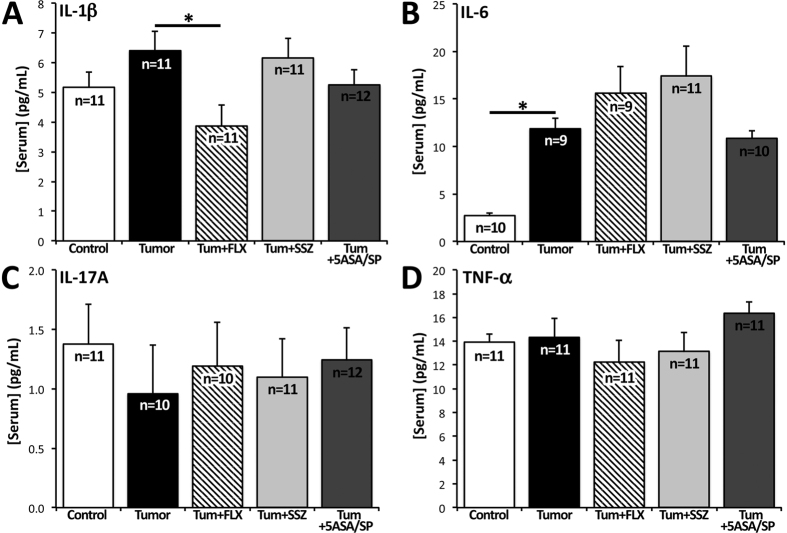
Serum level of pro-inflammatory cytokines for the 5 experimental groups: control, tumour, tum+FLX, tum+SSZ, tum+5-ASA/SP.(A) FLX-treated mice had a significantly lower level of serum IL-1β compared to untreated tumour mice (P = 0.022). (B) Untreated tumour-bearing mice had higher levels of serum IL-6 compared to control mice (P = 0.015). (C) Serum IL-17A did not differ between any experimental groups. (D) Serum TNF-α did not differ between any experimental groups. Data are presented as mean ± SEM. Results were analyzed using one-way ANOVA. The Holm-Šidák correction was used to correct for multiple comparisons. *P < 0.05.